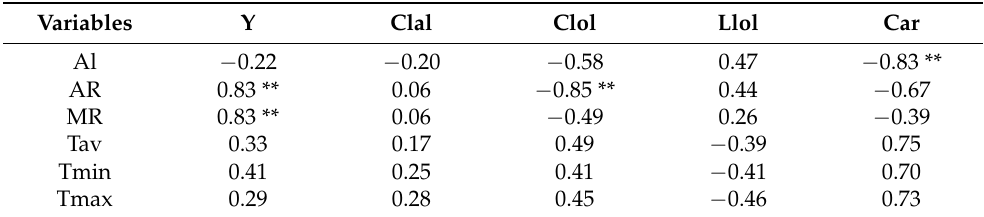
Figure 1. The essential oil yield of kaffir lime leaves in four growing locations. Note: in the bar chart of yield, the different alphabet above the rectangular bar is significantly different based on the Duncan’s multiple range test at α 5%; the error bar represents the standard deviation. Table 9. Pearson correlation coefficient of kaffir lime leaves essential oil (yield and main composition) and geo-climatic factor (altitude, temperature, and rainfall).